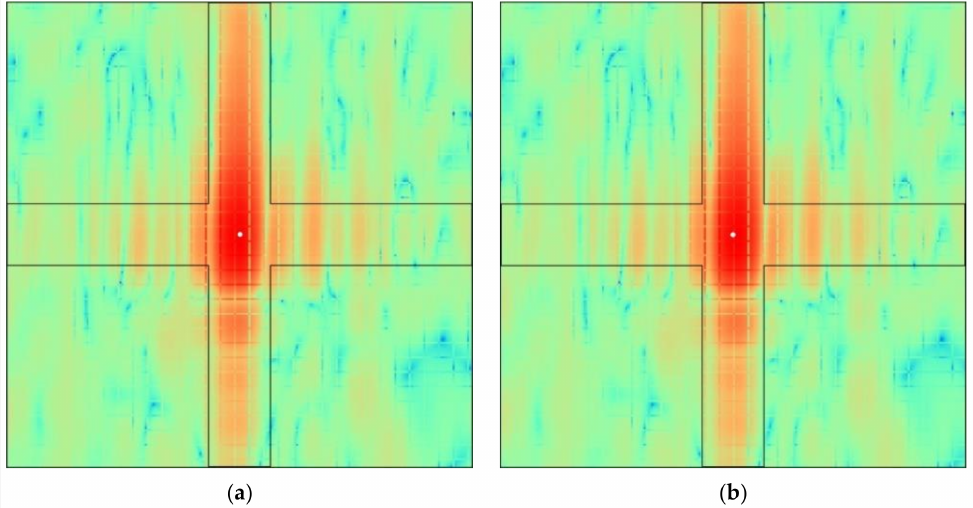
Figure 11. Integral window of corner reflector CR03 before and after center point position optimiza- tion: ( a ) maximum center method; ( b ) sliding window method.